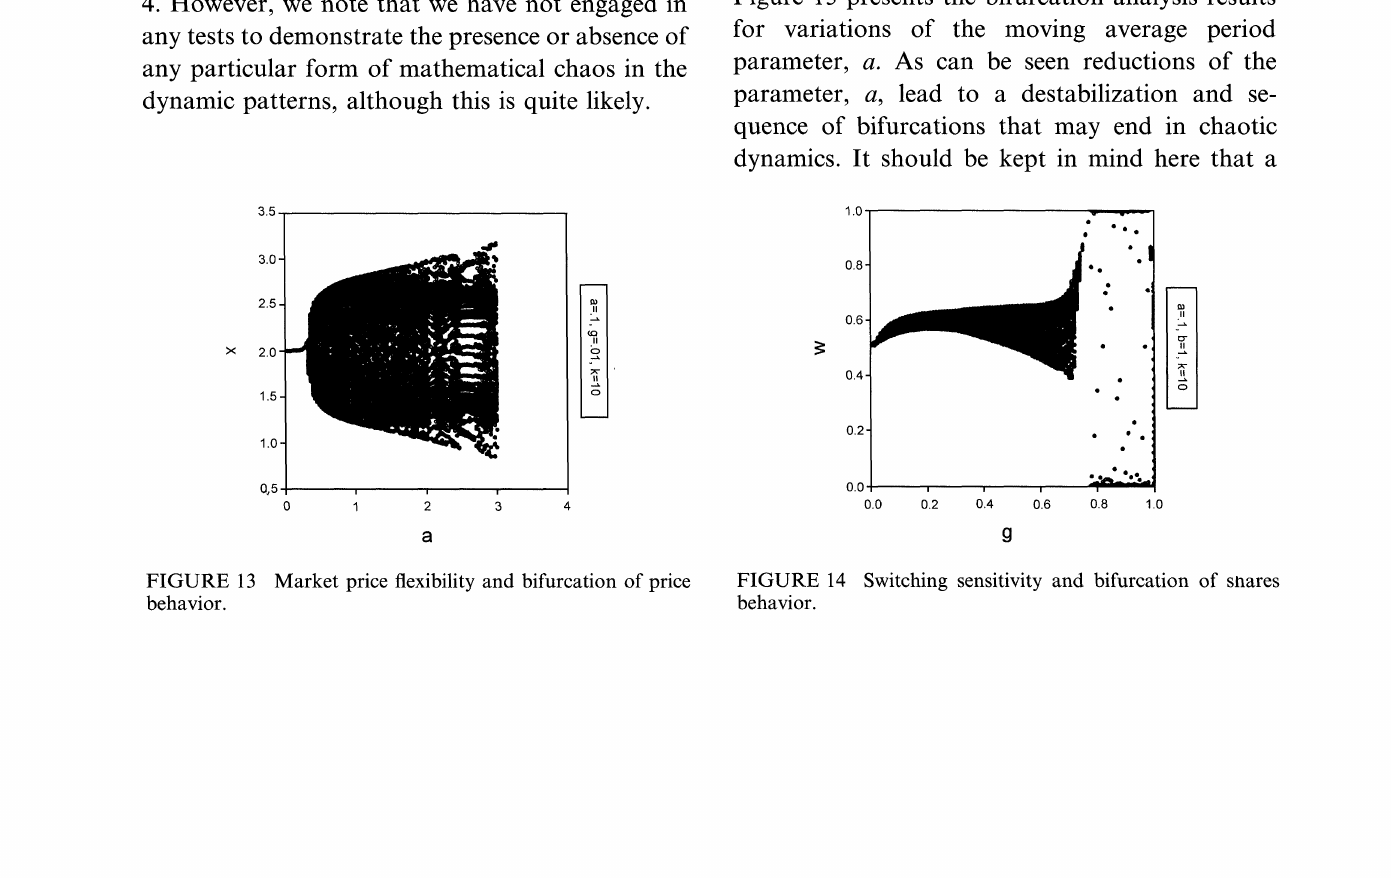
FIGURE 13 behavior.